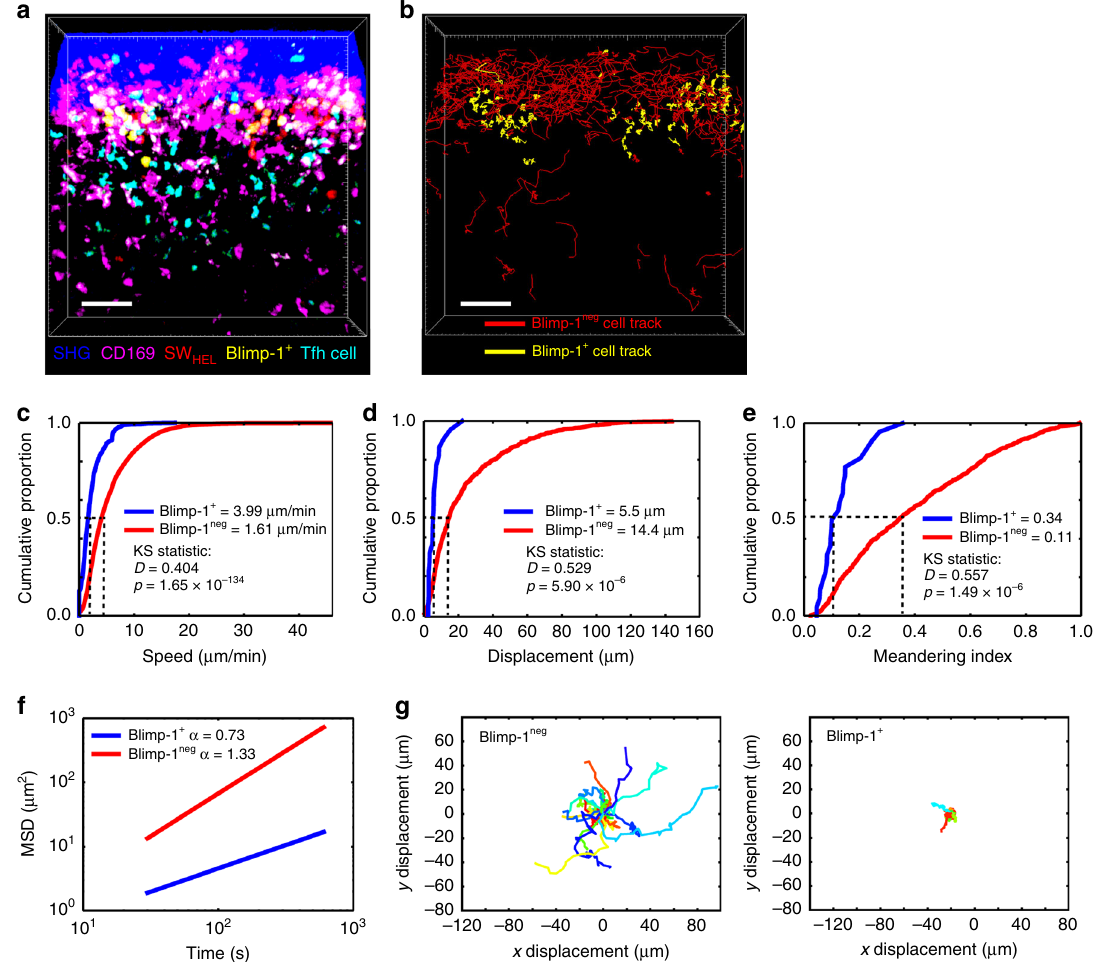
Fig. 5 Blimp-1 expression identi fi es two populations of SPF cells. a Maximum intensity projection (360 × 360 × 20 μ m) 5 days after HEL-OVA secondary immunisation. SW HEL B cells (red), Blimp-1 + SW HEL B cells (yellow, from co-expression of red and green), Tfh cells (cyan), CD169 + SCS macrophages (pink), SHG (blue). Scale bar = 50 μ m. b Cell tracking analysis of a . Blimp-1 + SW HEL B cell tracks (yellow), Blimp -1 neg SW HEL B cell tracks (red) in the SPF. See also Supplementary Movie 6. Scale bar = 50 μ m. c CDF plot of speed for Blimp-1 + (blue) and Blimp -1 neg SW HEL B cells (red). d CDF plot of displacement Blimp-1 + (blue) and Blimp -1 neg SW HEL B cells (red). e CDF plot of meandering index for Blimp-1 + (blue) and Blimp -1 neg SW HEL B cells (red). KS statistics refer to Kolmogorov – Smirnov statistics. f Mean squared displacement (MSD) plot of Blimp-1 + (blue) and Blimp -1 neg SW HEL B cells (red). g Representative tracks for Blimp-1 + and Blimp -1 neg cells in the SPF. Data are representative of 5 independent